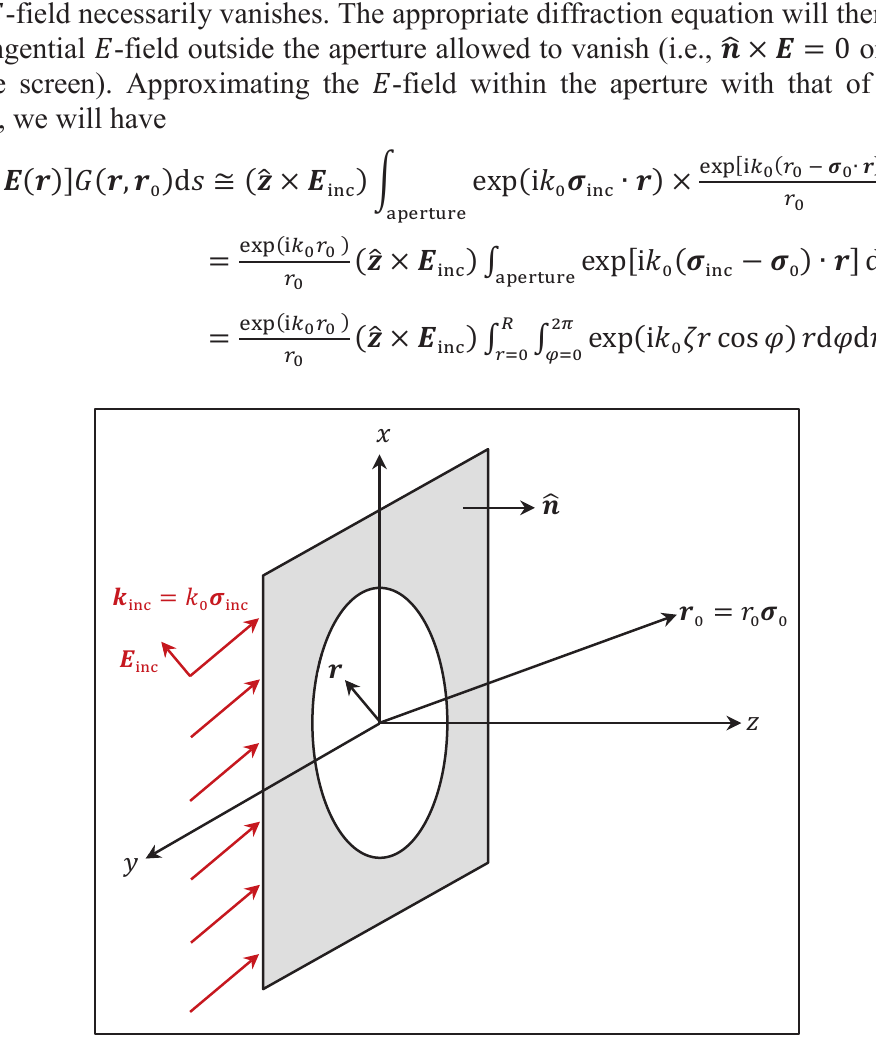
and (cid:2252) , respectively. (cid:2919)(cid:2924)(cid:2913) (cid:3167)(cid:3172)(cid:3161) is in the far field; that is, (cid:1870) and (cid:2252) have = (cid:1870) (cid:2252) (cid:1576) (cid:1844) . The unit-vectors (cid:2252) (cid:3116) (cid:3116) (cid:3116) (cid:3116) (cid:3167)(cid:3172)(cid:3161) (cid:3116) ) and ( (cid:2016) ) . The projection of the vector (cid:2252) onto the (cid:1876)(cid:1877) - , (cid:2030) , (cid:2030) (cid:3398) (cid:2252) (cid:3167)(cid:3172)(cid:3161) (cid:3167)(cid:3172)(cid:3161) (cid:3116) (cid:3116) (cid:3167)(cid:3172)(cid:3161) (cid:3116) onto the (cid:1876)(cid:1877) -plane of the (cid:3398) (cid:2252) (cid:3167)(cid:3172)(cid:3161) (cid:3116)